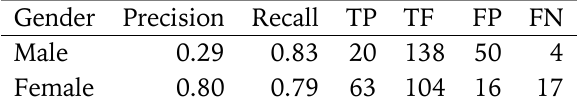
Precision and recall of automatic clustering. TP denotes the number of true positives, TF denotes the number of true negatives, FP denotes the number of false positives, and FN denotes the number of false